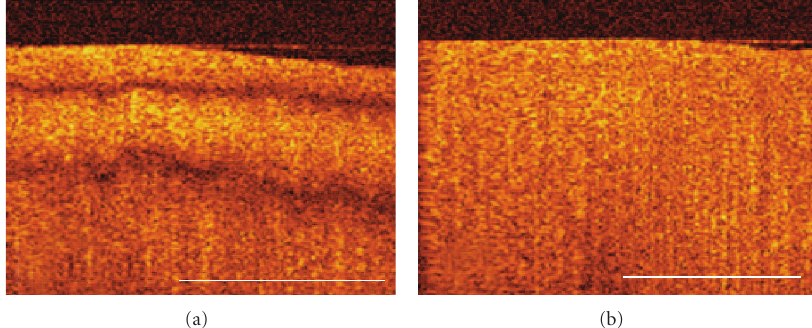
Figure 1: Cartilage OCT form birefringence. (a) OCT image of cartilage with OCT form birefringence where distinct dark bands create a multilayered appearance. (b) OCT image of cartilage without OCT birefringence. In cartilage graded to be without OCT form birefringence, there were no recognizable banding patterns in any of the four scan orientations. Scale bar = 1mm.